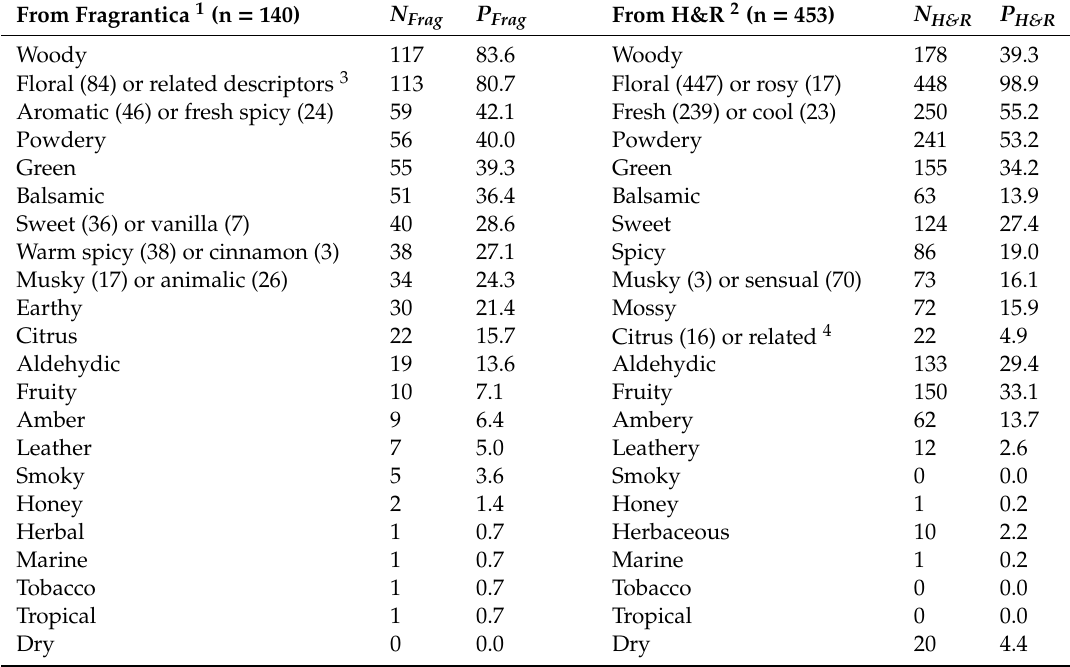
1 Sorted in decreasing order of occurrence. Similar descriptors were grouped together to ease the comparison (e.g., “sweet (36) or vanilla (7)”); the number of occurrences is indicated within parentheses. 2 Descriptors applied either to the top, middle, or base note. 3 White floral (67), yellow floral (7), rose (13), or tuberose (8). 4 Orange (1) or agrumy